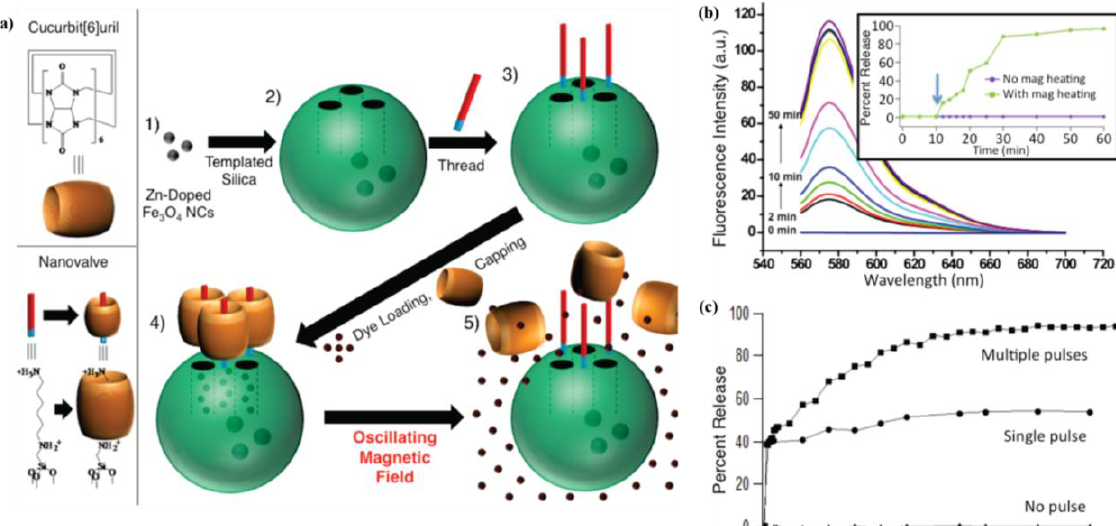
Figure 8. ( a ) Illustration of synthetic route of magnetically activated release system (MARS) nanoparticles. ZnNCs ( 1 ) are synthetically positioned at the core of the mesoporous silica nanoparticles ( 2 ). The base of the molecular machine is then attached to the nanoparticle surface ( 3 ). Drug is loaded into the particle and capped ( 4 ) to complete the system. Release can be realized using remote heating via the introduction of an oscillating magnetic field ( 5 ). The particles and machines are not drawn to scale. Cargo is released using magnetic actuation; In ( b ), the MARS nanoparticles were continuously exposed to the magnetic field. The inset shows the data as a release profile; In ( c ), a sample was kept at 0 °C and exposed to pulses of the magnetic field. A single AC magnetic field exposure (●) exhibited ~40% cargo release after an initial 1 min pulse. Multiple pulses performed at 1, 3, 5, 7 and 9 min and then every 20 min for 270 min (■) enabled more dye release